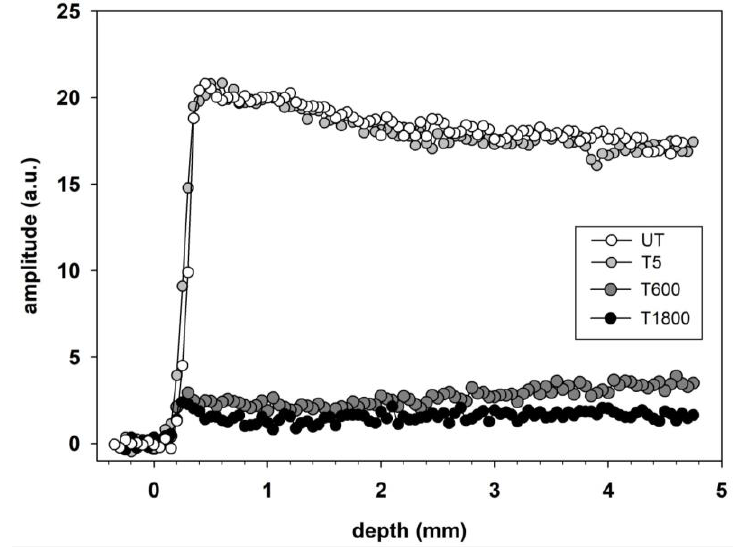
Figure 9. 1 H NMR depth profile collected on water-saturated untreated calcarenite (UT), and calcarenite treated with tetraethoxysilane (TEOS) for 5 s (T5), 600 s (T600), and 1800 s (T1800).